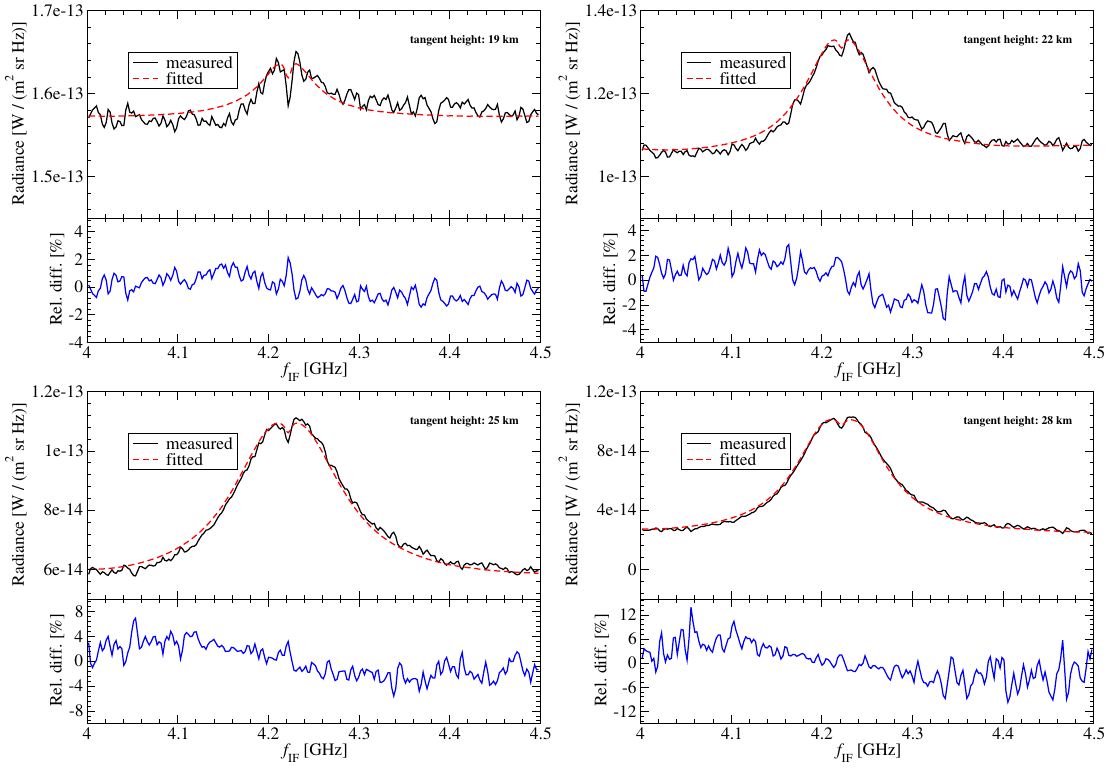
Figure 6. Comparison of the measured and modeled TELIS HCl spectra in segment 1. The dedicated measurement identifier is 20044 and the corresponding local oscillator frequency ( f LO ) is 1877.6323GHz. Four spectra are plotted for tangent heights at 19, 22, 25, and 28km, respectively. For each tangent height, the relative differences with respect to the measured spectrum are shown in the bottom panel.